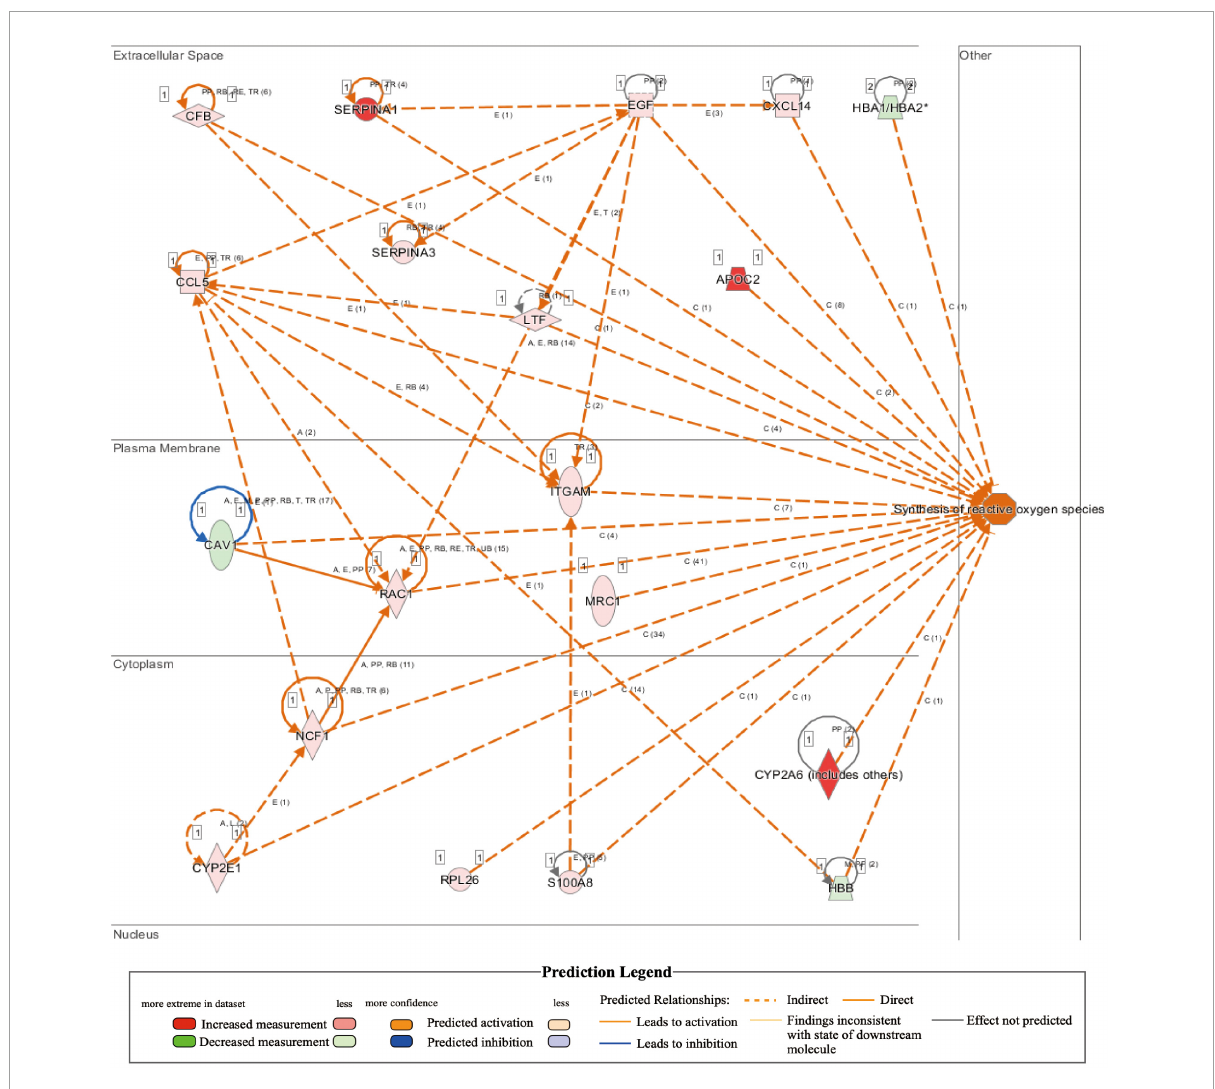
FIGURE7 Activated regulation of reactive oxygen species synthesis played a role in heart failure induced by the loss of cardiomyocyte-derived BDNF: IPA revealed that the synthesis of reactive oxygen species in cardiomyocyte-derived BDNF conditional knockout hearts was higher than that in wild-type hearts ( p -value = 6.05E-06; activation z -score = 2.418). The interaction network demonstrated that 19 genes (16 upregulated genes and 3 downregulated genes) were included, as shown in the interaction network for the activation of reactive oxygen species synthesis in cardiomyocyte-derived BDNF conditional knockout hearts.